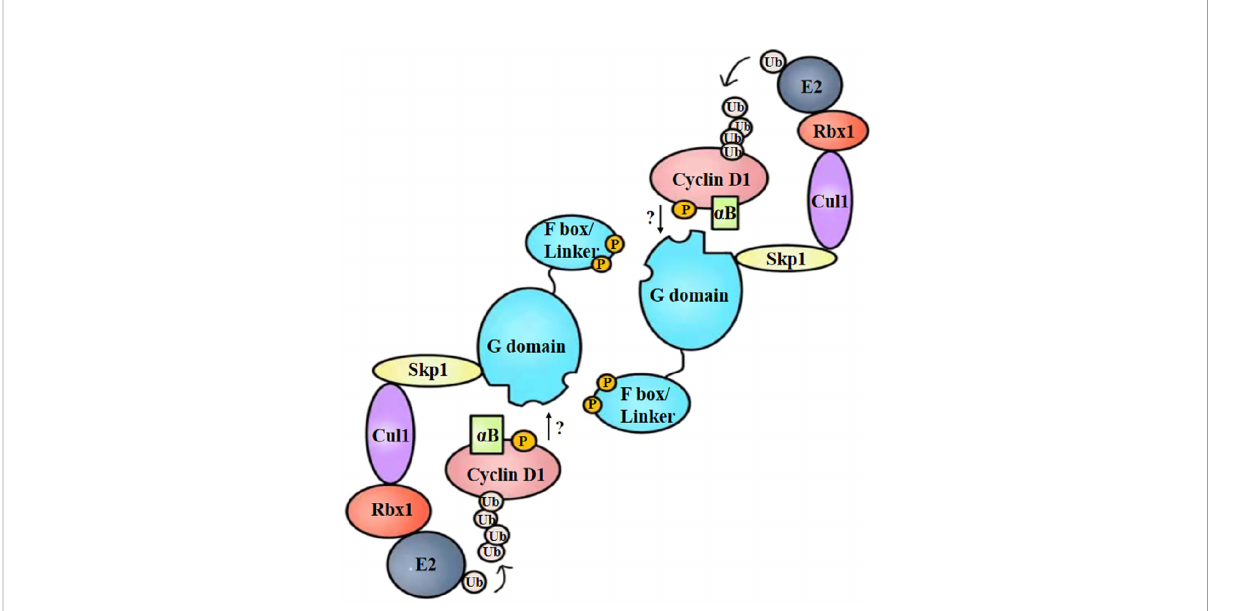
FIGURE 5 Structural diagram of FBX4-mediated cyclin D1 ubiquitination. After phosphorylation and alpha B-crystalline combination, cyclin D1 is recruited by dimerized FBX4. FBX4 also recruits the remainder of E3 ubiquitin ligase and E2 ubiquitin ligase, mediating cyclin D1 ubiquitination. a B, alpha B-crystalline; Ub,